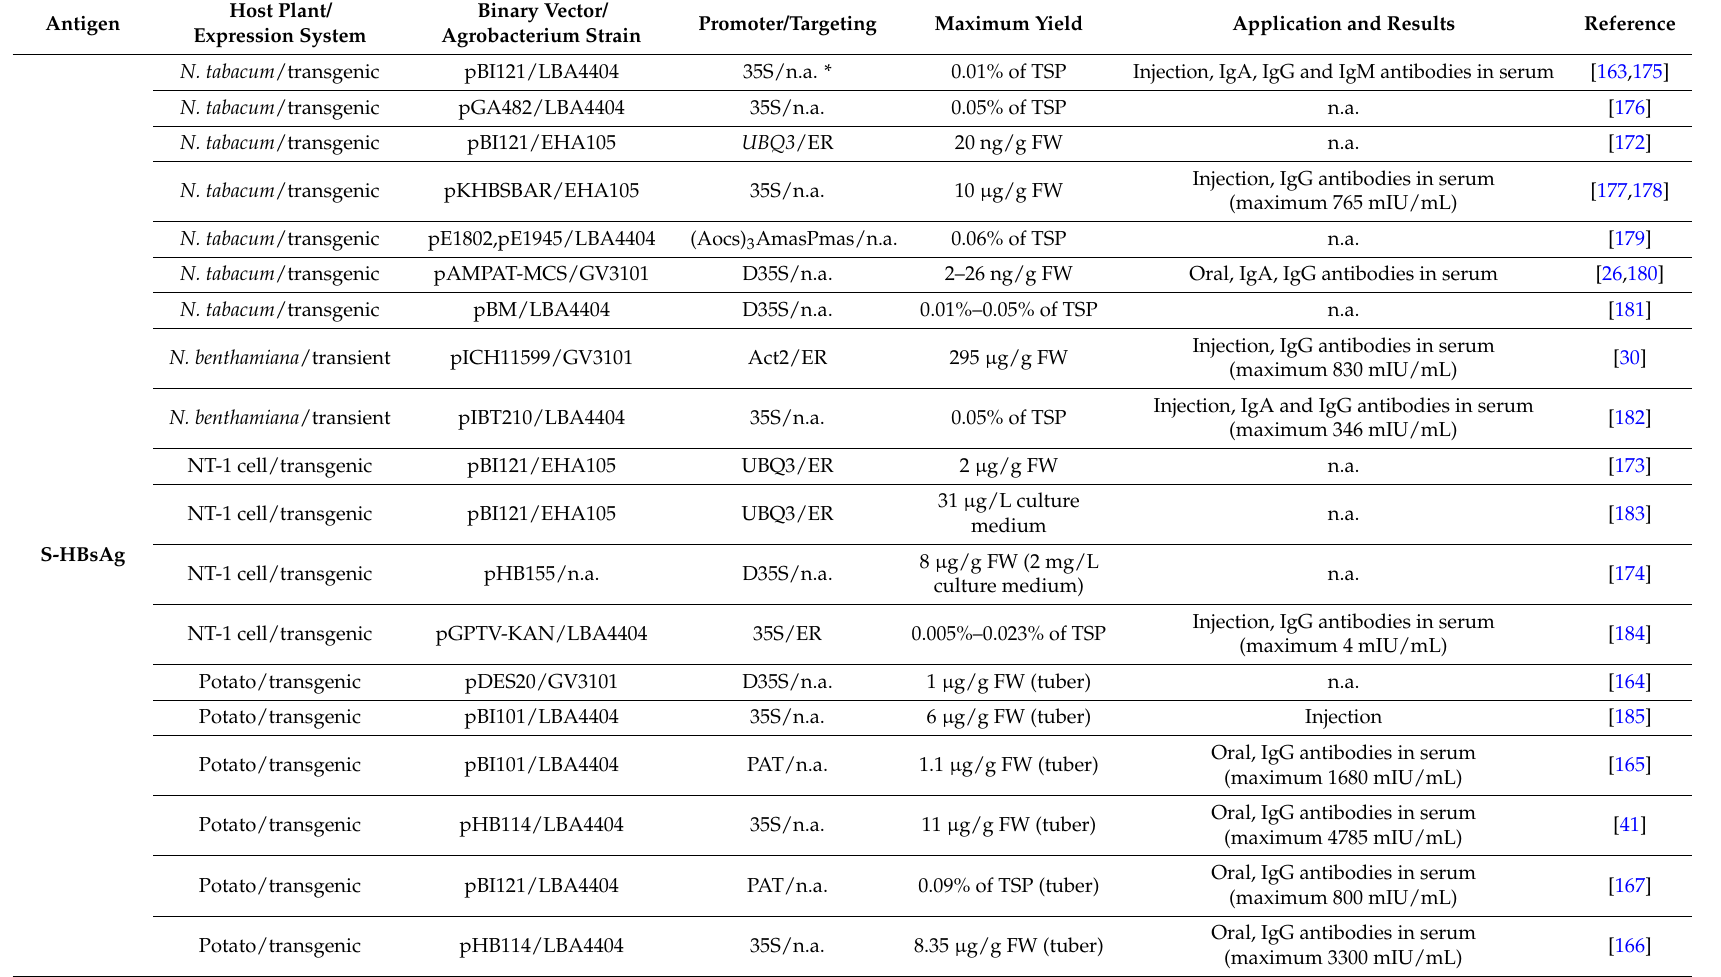
Table 3. Published studies on plant-derived hepatitis B virus (HBV) antigens and expression